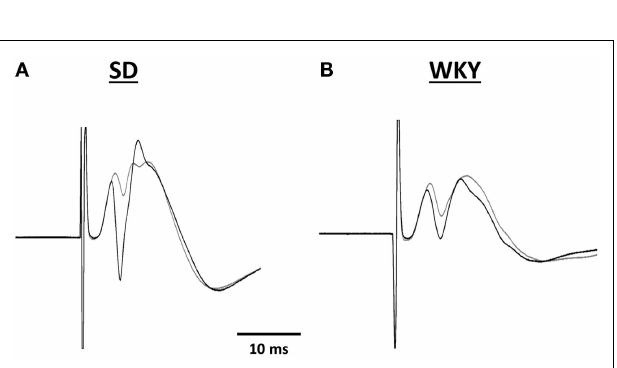
FIGURE 4 |The volume of the hippocampus and cortex was significantly reduced inWKY compared to SD rats . In contrast, strain differences were not observed for striatum and corpus callosum.